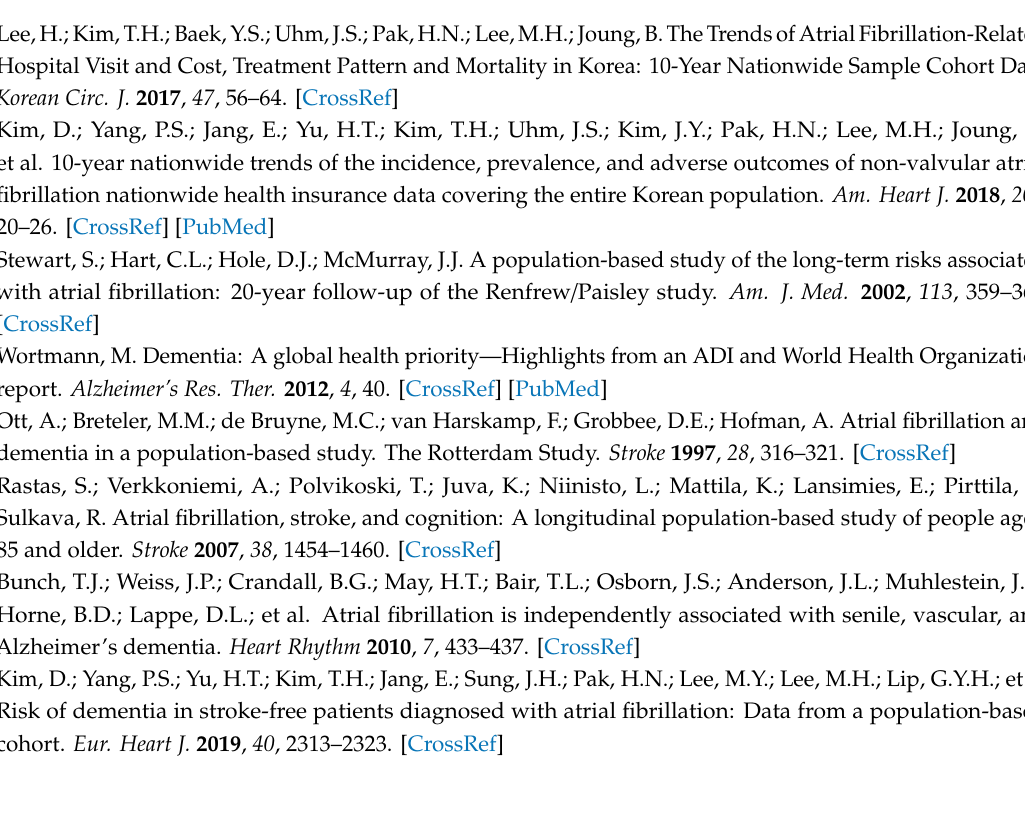
Table S1: Definitions and ICD-10 codes used for defining the comorbidities and clinical outcomes, Table S2: Baseline characteristics of overall population and propensity score (PS)-matched population, Table S3: Incidence of dementia during follow-up periods according to the AF status in the propensity score-matched population, Table S4: Types of dementia during follow-up periods according to the AF status in the propensity score-matched population, Figure S1: Cumulative incidence of dementia before (A) and after (B) censoring for stroke in the propensity score-matched population, Figure S2: Hazard ratios for dementia per decade of age with atrial fibrillation in the propensity score-matched